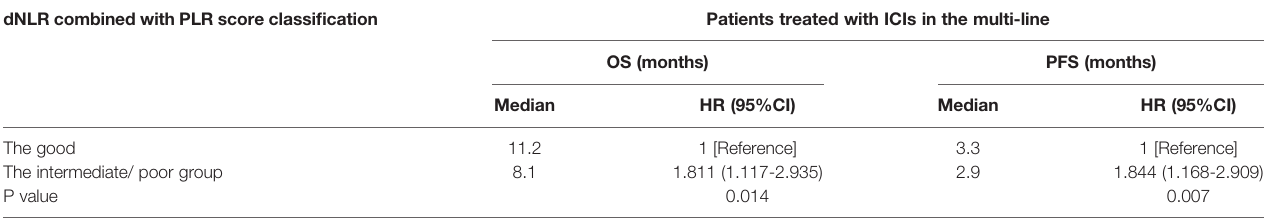
TABLE 7 | Univariate analyses of the good group and the intermediate/poor group associated with OS and PFS of AGC patients treated with ICIs in the multi-line. dNLR combined with PLR score classi fi cation Patients treated with ICIs in the multi-line